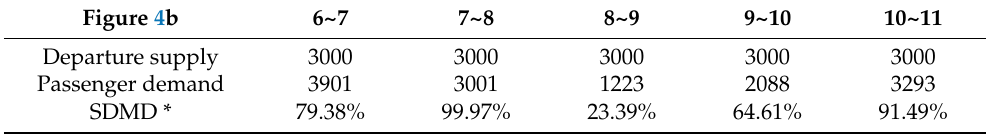
Table 5. Details of supply and demand matching degree of single-cycle timetable in scenario 1.